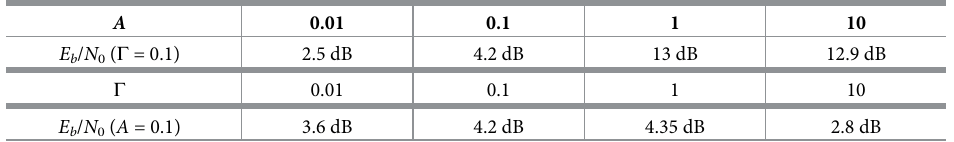
Table 2. Effect of AWAN channel parameters on performance of the optimized FFT BP.